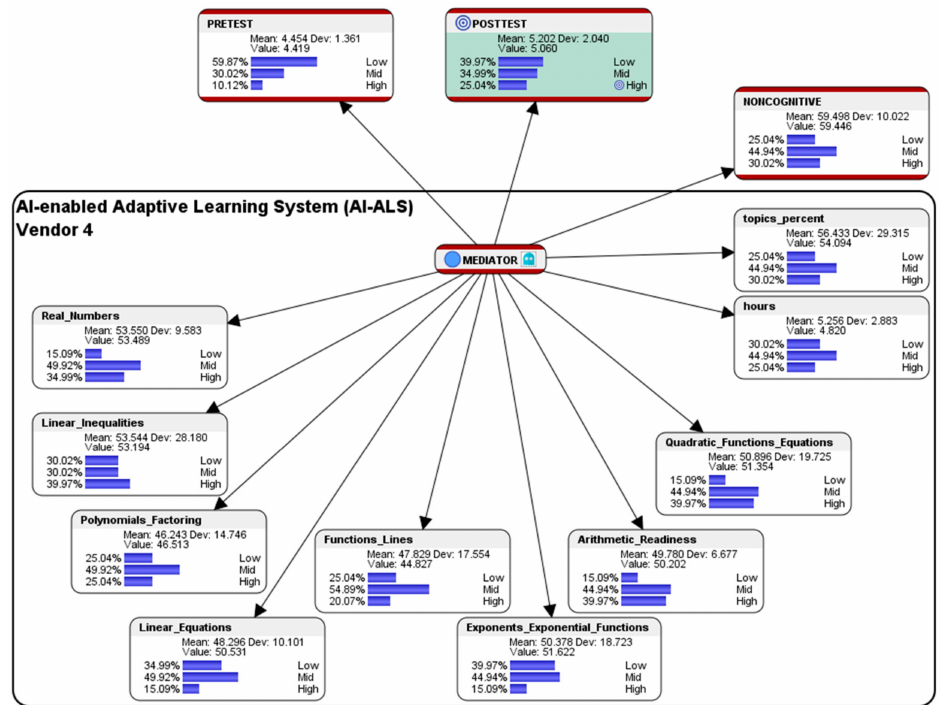
Figure 10. BN model of the students who had used the AI-ALS from Vendor 4 (N = 20